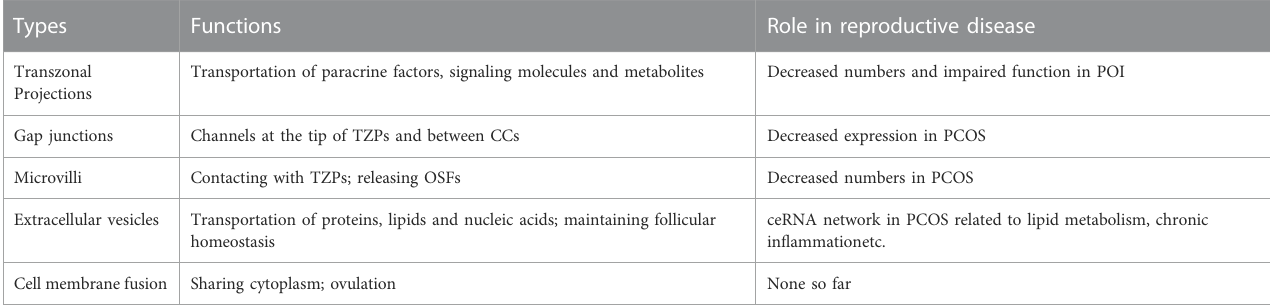
TABLE 1 Schematic description of the functions of intercellular communications and their roles in related reproductive diseases. TZP, transzonal projection; CC, cumulus cell; OSF, oocyte secreted factor; PCOS, polycystic ovary syndrome; POI, primary ovarian insuf fi ciency.